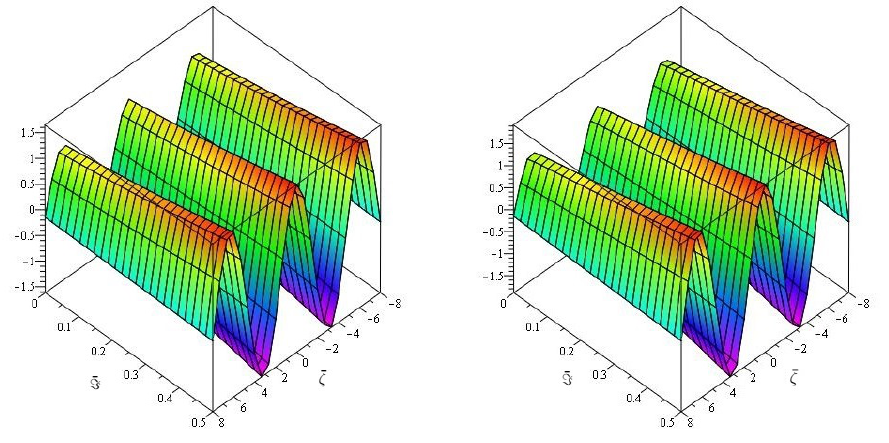
Figure 7. The first graph of analytical solution of β = 1 and second is β = 0.8 for Example